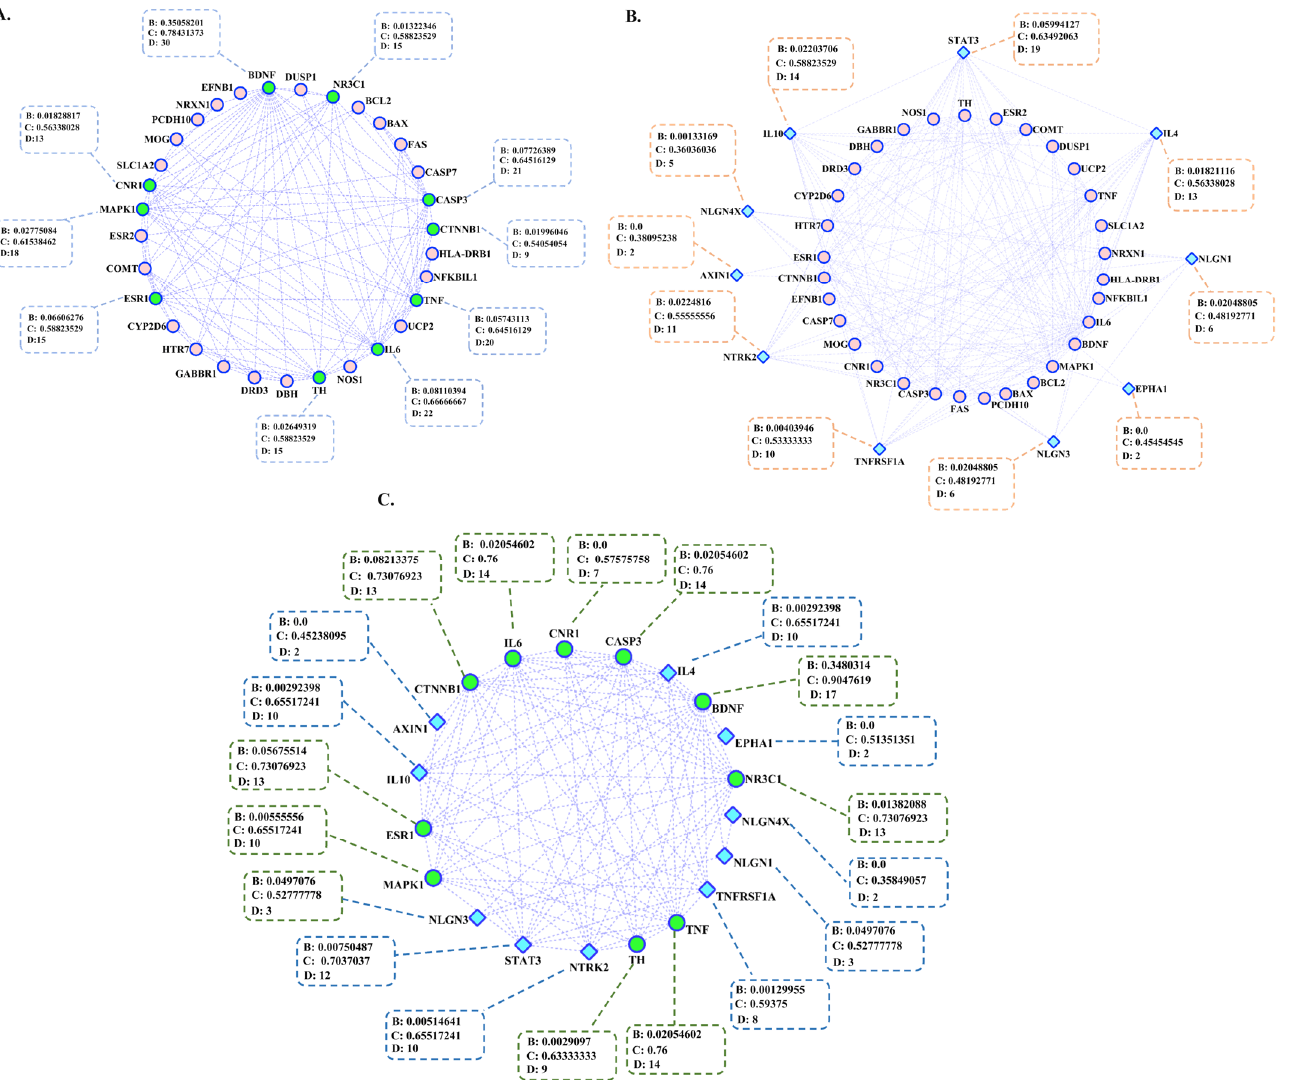
Figure 2. Reconstructed genetic networks for MS and OCD. ( A ) Genetic network for MS-OCD shared genes. The current network is comprised of 32 nodes (genes) and 121 edges (interactions). Green nodes represent genes with greater network features (hub genes in the network; network parameters: density = 0.254, diameter = 5, centralization = 0.513, clustering coefficient = 0.583). ( B ) Genetic network for common and ten top genes between MS and OCD. Circular pink nodes represent shared genes and external blue diamond nodes represent novel predicted genes for MS and OCD (network parameters: density = 0.239, diameter = 5, centralization = 0.537, clustering coefficient = 0.662). ( C ) Genetic networks for 10 genes with higher topological features between MS and OCD shared genes (green nodes) and 10 novel predicted genes (blue nodes) (network parameters: density = 0.489, diameter = 4, centralization = 0.450, clustering coefficient = 0.836). B: betweenness centrality; C: closeness centrality; D: degree.